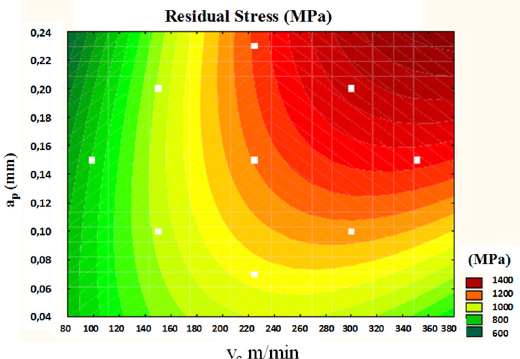
x v ) for the residual stress adopting p c